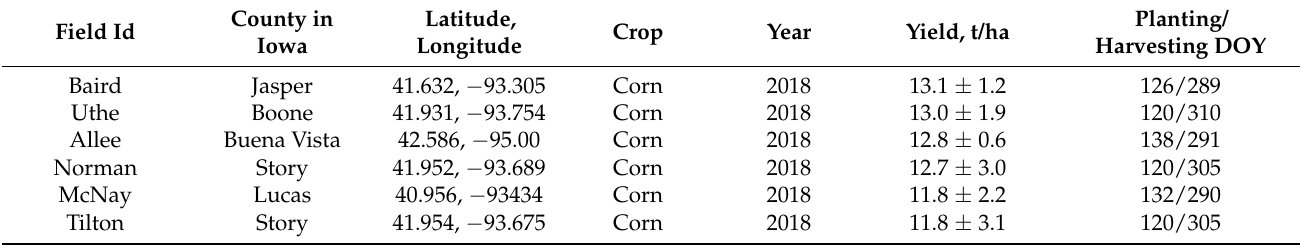
Table A1. Detailed information on corn and soybean fields used in the study. DOY is the day of the year. Shown are per-field average yield and standard deviation